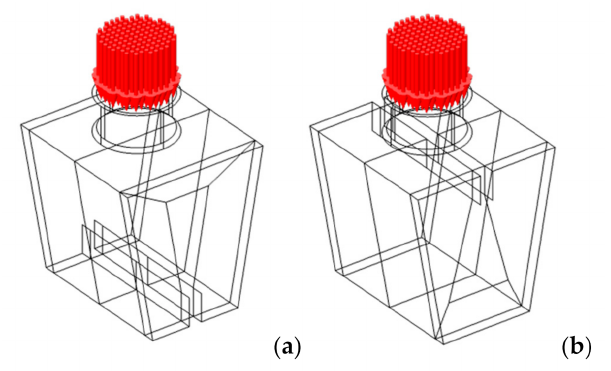
Figure 12. Loads applied to the 1st design with bottom ( a ) and top ( b )